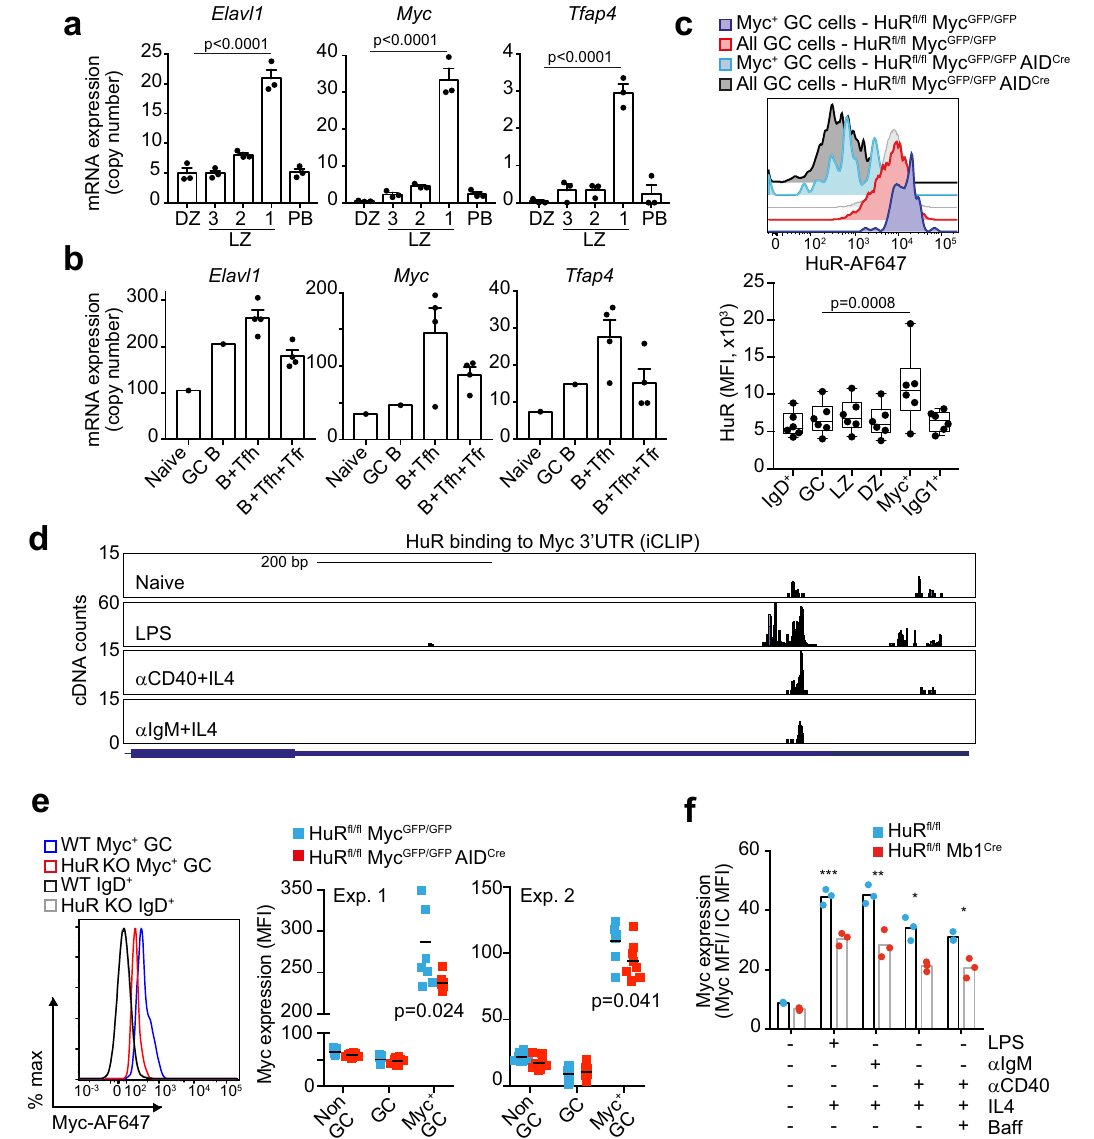
Fig. 4 HuR regulates Myc expression. a Elavl1 , Myc and Tfap4 mRNA expression in DZ B cells and in NP + IgG1 + LZ GC B cells (grouped by the amount of help received from Tfh cells as Fr. 1, Bcl6 lo CD69 hi ; Fr. 2, Bcl6 hi CD69 hi ; and Fr. 3, Bcl6 hi CD69 lo ) and in splenic plasmablasts (PB, NP + IgG1 + CD138 hi ) (GSE109732 7 , n = 3 samples per group, mean ± SD, DESeq2 analysis with BH correction of p values). b Elavl1 , Myc and Tfap4 mRNA expression in FO and GC B cells and in B cells co-cultured with Tfh cells or Tfh and Tfr (T follicular regulatory) cells (GSE82003 58 , n = 1 (naive and GC B cells) or n = 4 (B + Tfh cells and B + Tfh + Tfr cells), mean ± SD). c HuR protein expression in Myc + GC B cells. Top panel, histogram showing HuR staining in all GC B cells or in Myc + GC B cells from HuR fl / fl Myc GFP/GFP and HuR fl / fl Myc GFP/GFP AID Cre mice at day 7 after immunisation. Bottom panel, mean fl uorescence intensity (MFI) of HuR in naive IgD + , GC, LZ, DZ, Myc + GC and IgG1 + GC B cells (representative data from 1 of the 2 independent experiments, n = 6 mice, data presented as box plots showing the mean, 25 – 75% range and whiskers from Min. to Max., two-way ANOVA and Tukey ’ s post-test). d Analysis by iCLIP of in vivo binding of HuR to the 3 ’ UTR of Myc in follicular B cells treated or not with LPS, α CD40 + IL4 or α IgM + IL4 for 48 h. e Myc protein expression analysis by fl ow cytometry in GC B cells. Left panel shows a histogram of Myc expression in positively selected GC B cells (gated as shown in Fig. 3f) from HuR fl / fl Myc GFP/GFP and HuR fl / fl Myc GFP/GFP AID Cre mice at day 8 upon immunisation with NP-KLH in alum. Right panel, quantitation of the mean fl uorescence intensity of Myc in GFP + GC B cells (data of the 2 independent experiments performed is presented, n = 7 or n = 8 per genotype depending on the experiment, two-sided Mann – Whitney test). f Myc protein expression in follicular B cells from HuR fl / fl and HuR fl / fl Mb1 Cre mice activated in vitro for 3 h with the mitogens and cytokines indicated (data representative from 1 of the 3 independent experiments performed, n = 3 per group, two-way ANOVA and Tukey ’ s post-test, * p < 0.05, ** p < 0.01, *** p < 0.001). Source data are provided as a Source data fi le. LZ GC cell type, but not on genotype (Supplementary Fig. 5a). We HuR de fi ciency does not globally alter the transcriptome of GC B con fi rmed this was not due to inef fi cient Cre-mediated deletion of cells but might affect mRNA abundance in a gene-speci fi c manner. HuR in HuR fl / fl AID Cre GC B cells as we did not detect reads Differential gene expression analysis showed that the expres- mapped to the fl oxed exon 2 of the Elavl1 gene in libraries from sion of >2000 genes changed between DZ and LZ GC B cells (false HuR KO cells (Supplementary Fig. 5b). Thus, we conclude that discovery rate (FDR) < 0.05) (Fig. 5a and Supplementary Data 1). NATURE COMMUNICATIONS| (2021) 12:6556